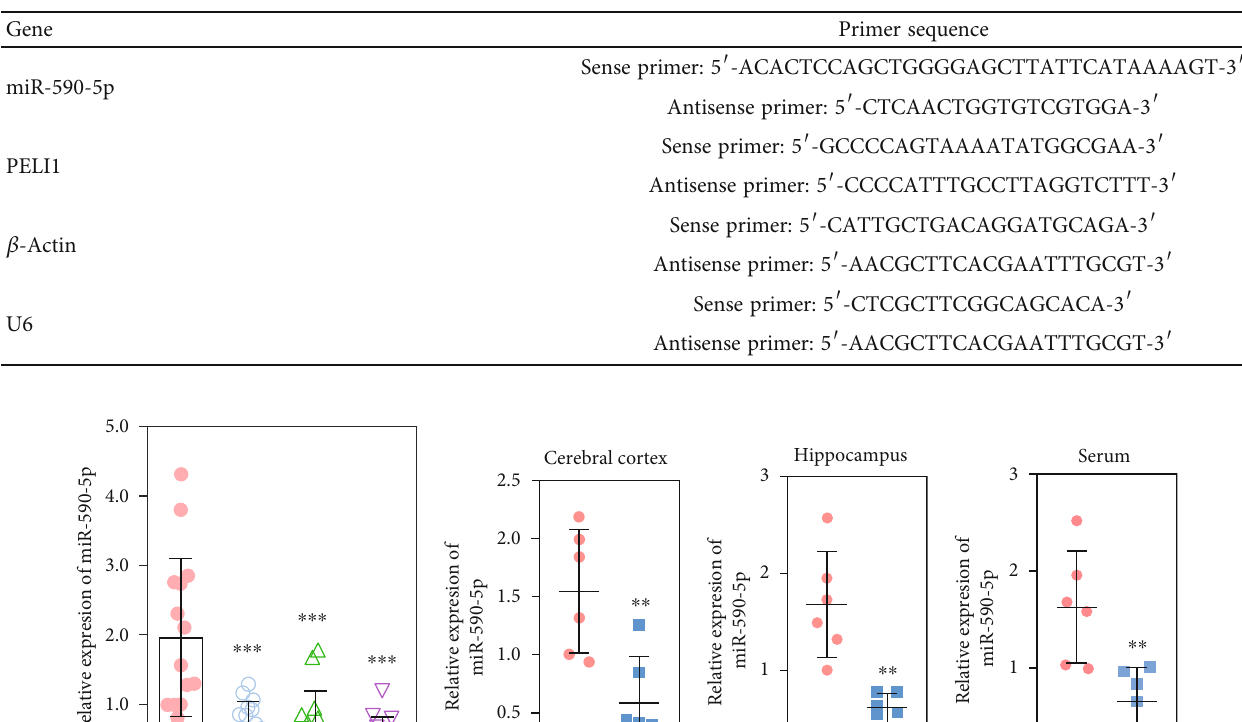
Table 1: Speci fi c primers for qPCR assay.